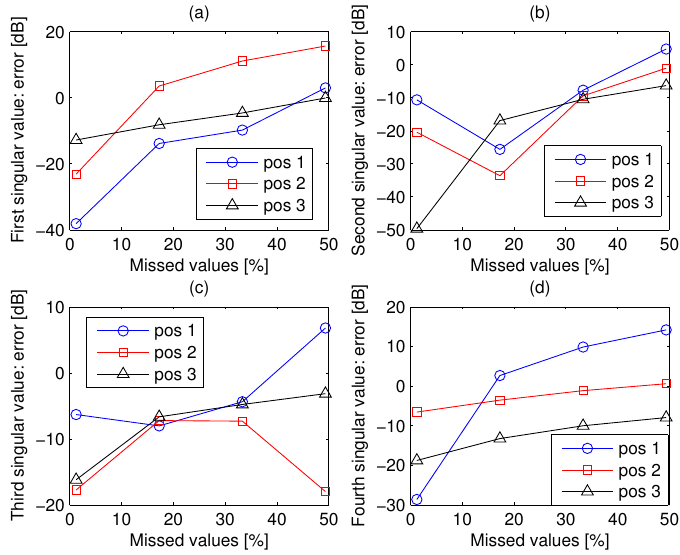
Figure 15. Estimation error (dB) of the first four singular values in the three positions shown in Figures 7d (pos 1), 10d (pos 2) and 11d (pos 3) versus the percentage of the missed elements of the channel